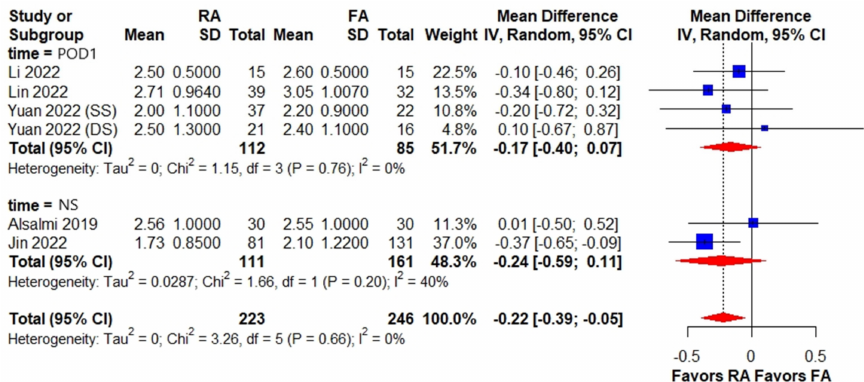
Figure 3. Forest plot of postoperative VAS among patients receiving RA PKP versus FA PKP. The forest plot demonstrates postoperative VAS among the RA PKP group versus the FA PKP group. The size of squares is proportional to the weight of each study. The result is summarized using weighted mean difference with corresponding 95% CI. Horizontal lines indicate the 95% CI of each study; red diamonds indicate the pooled estimate with 95% CI. CI, confidence interval, FA PKP, fluoroscopy-assisted kyphoplasty, NS, not-specified, POD1, postoperative day 1, RA PKP, robot- assisted kyphoplasty, VAS, visual analog scale [10–13,20].